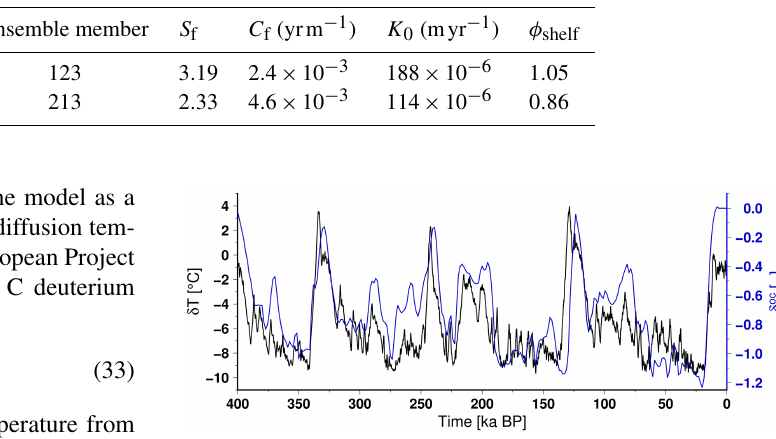
Figure 13. Climatic perturbation used in the 400kyr glacial– interglacial simulations for the near-surface air temperature, δT = (cid:16) (cid:17) δD , and for the sub-shelf basal melting rate modifier, δ oc = 1 /α i α oc (cid:49)T NA /T NA0